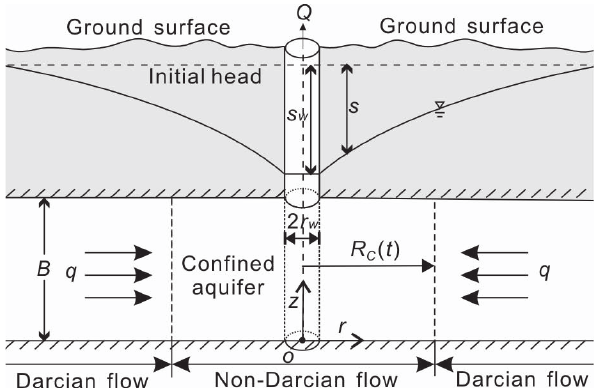
Figure 1. The schematic diagram of the non-Darcian flow into a fully penetrating pumping well considering the time-dependent crit- ical